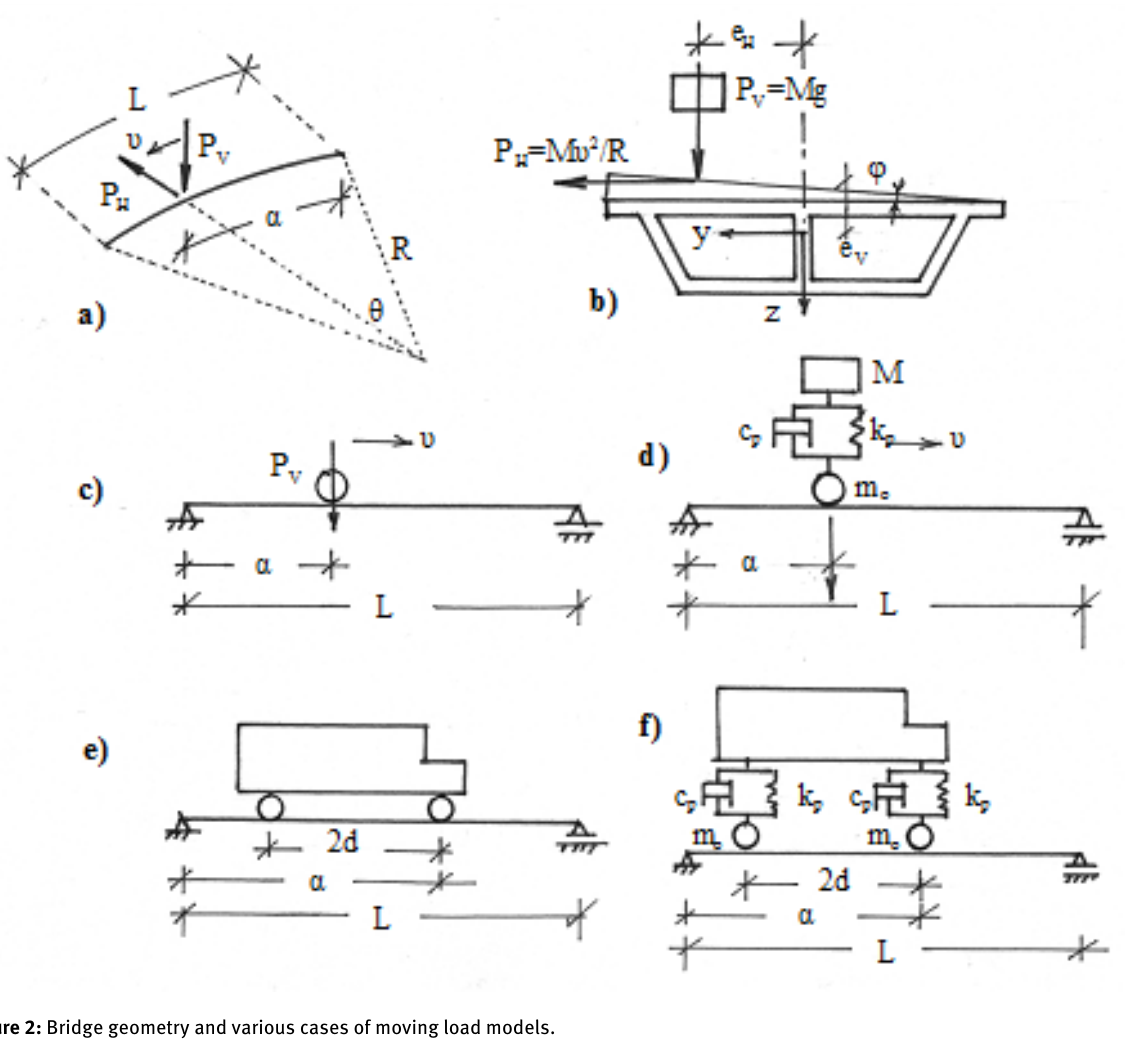
Figure 2: Bridge geometry and various cases of moving load models.